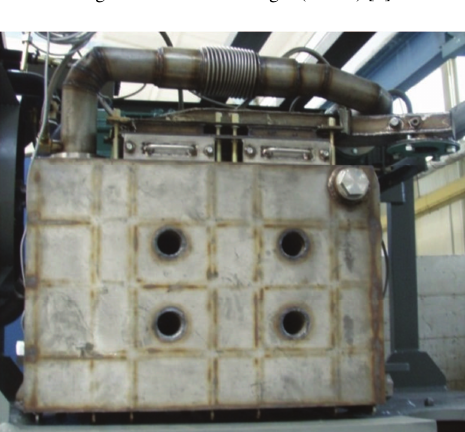
Fig. 4. Wet heat exchanger (model) [6]